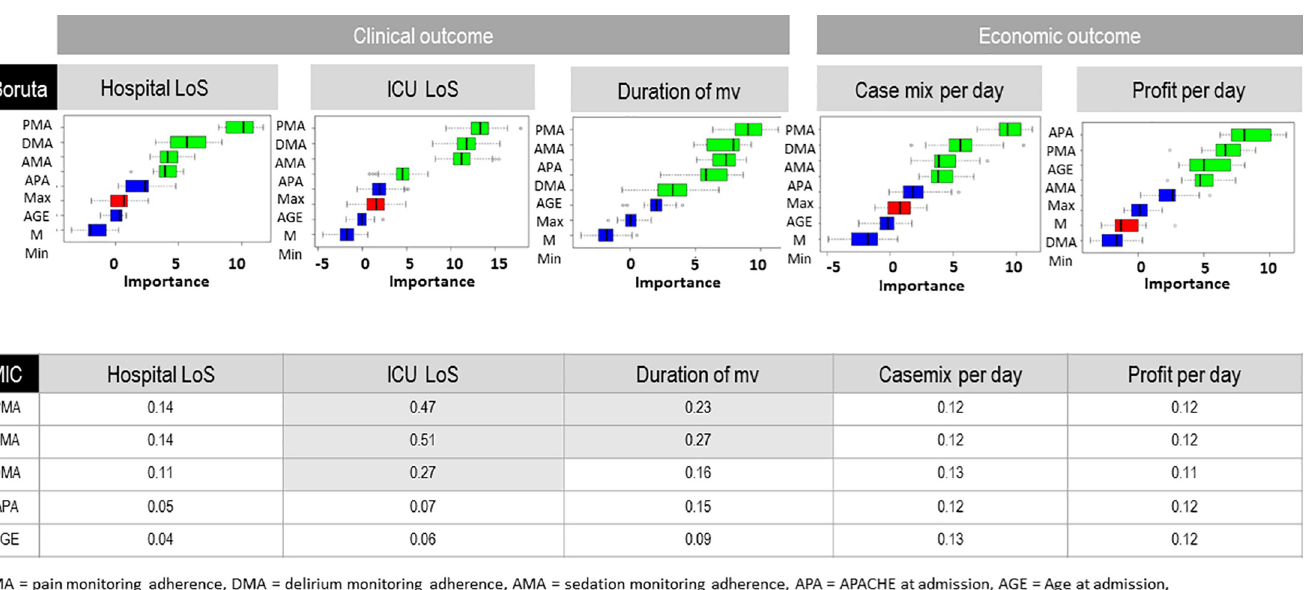
Fig 2. Results of Boruta and MIC for effects of monitoring adherence to clinical and economic outcome. The green predictor variables are deemed predictive by the Boruta algorithm while the red are not.